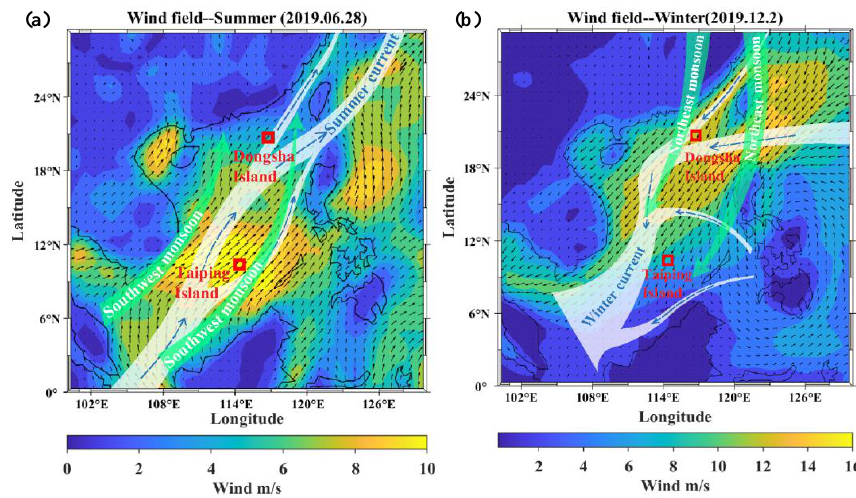
Figure 12. Distribution of wind field, monsoon and ocean current in the SCS. ( a ) Summer ( b ) Winter.